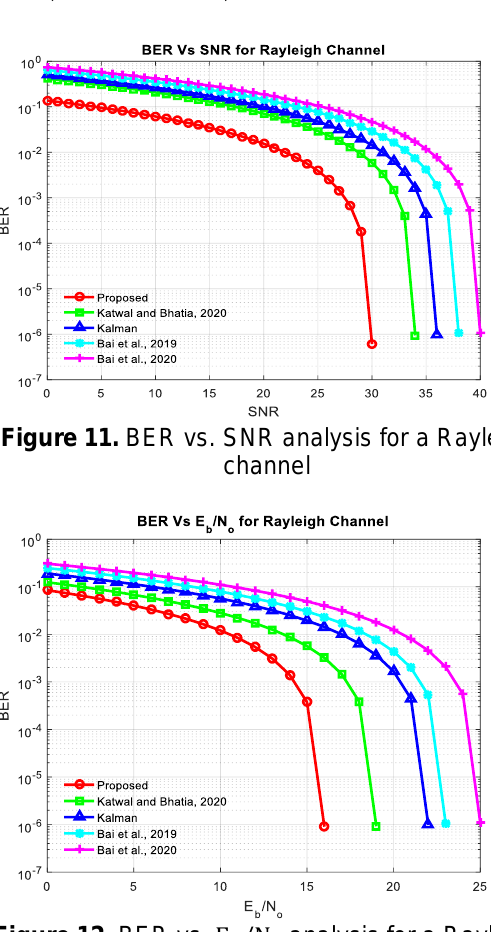
analysis for a Rayleigh /N b 0 channel